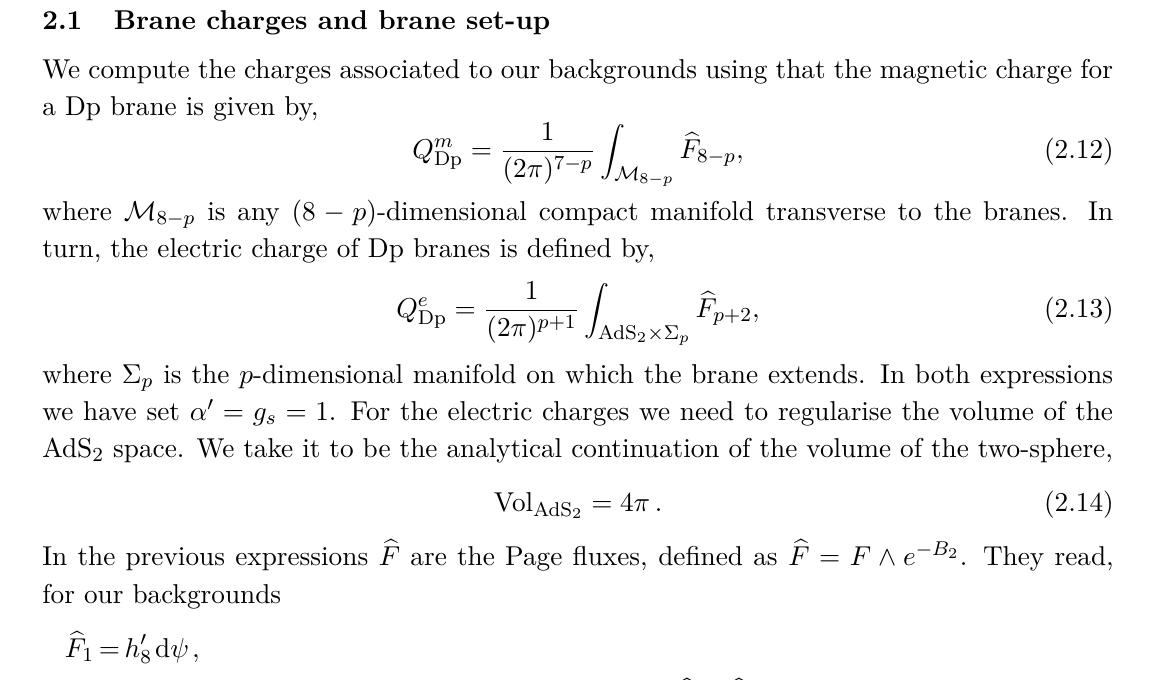
Figure 1 . Relations between the infinite family of AdS 3 backgrounds to massive IIA constructed in [23] (top left), the IIB AdS backgrounds studied in [1] (bottom left), the IIA AdS 2 constructed in [39] (top right), and the new AdS solutions in Type IIB given by eqs. (2.1)–(2.2) 2 (bottom